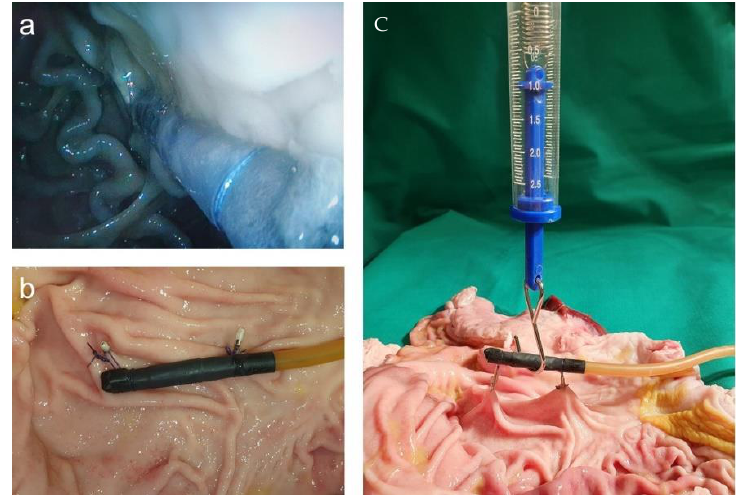
Figure 12. ( a ) Endoscopic view after the placement of magnetic field trap fixated with loops and endoscopic clips to the abdominal wall; ( b ) fixed magnetic field trap at the porcine wall; ( c ) strength measurements.